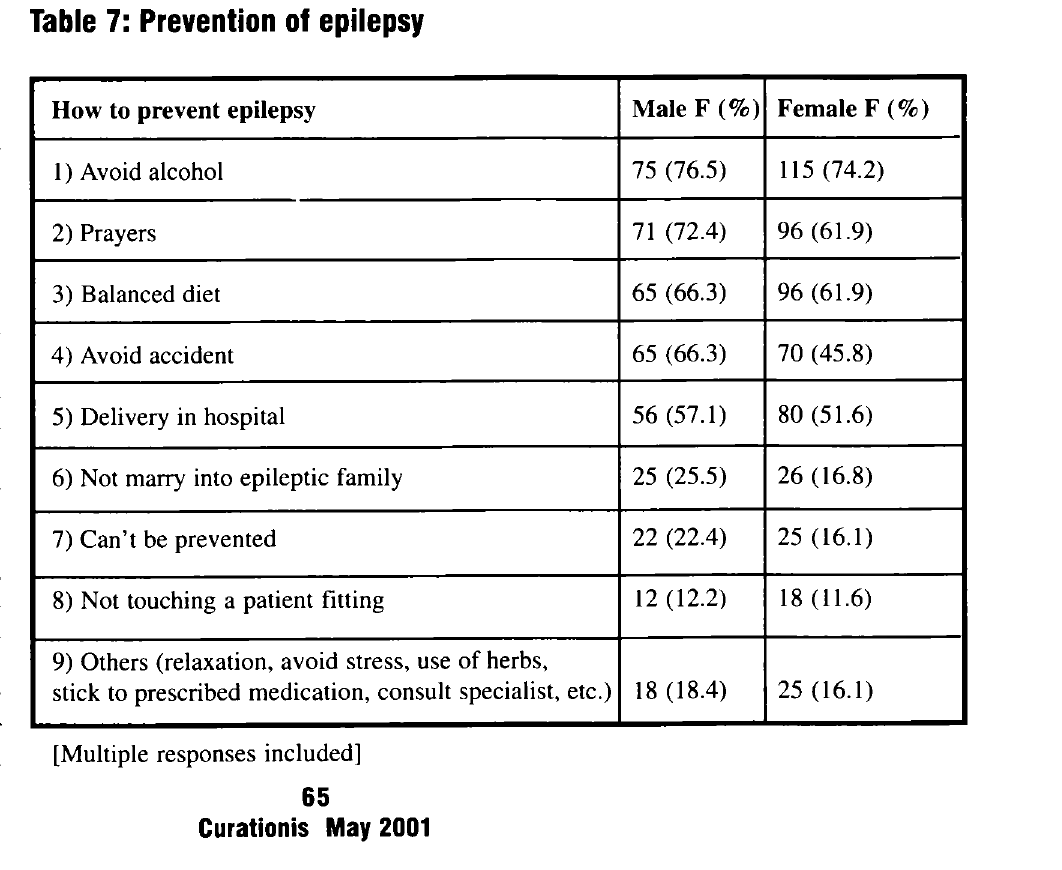
Table 7 : Prevention of